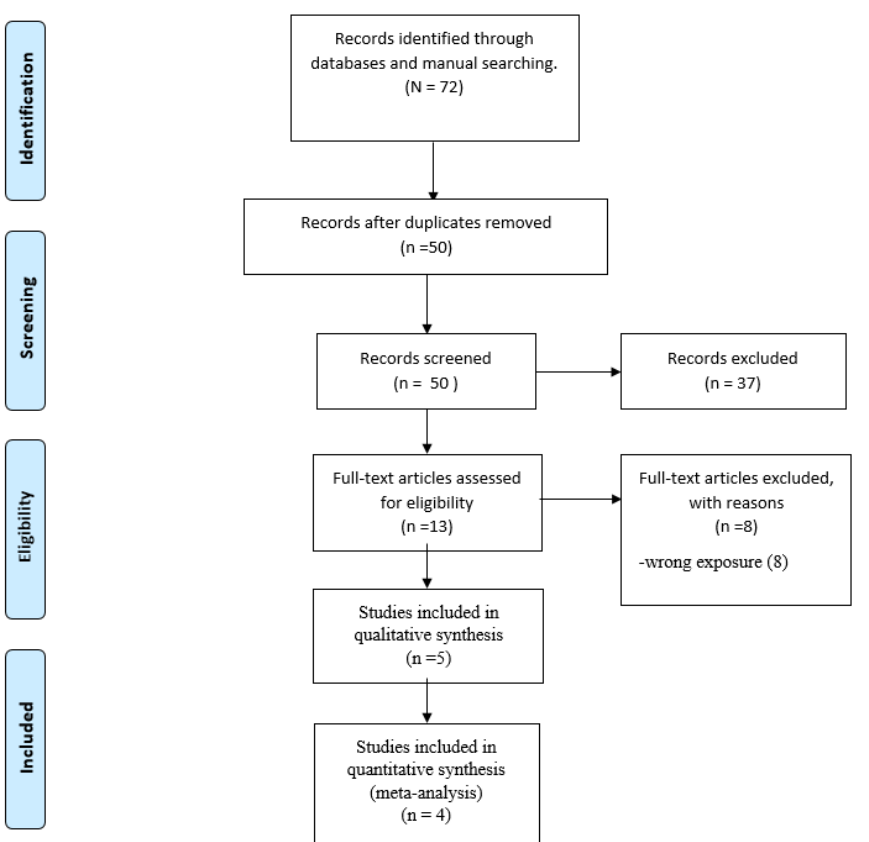
Figure 1. PRISMA flow diagram.